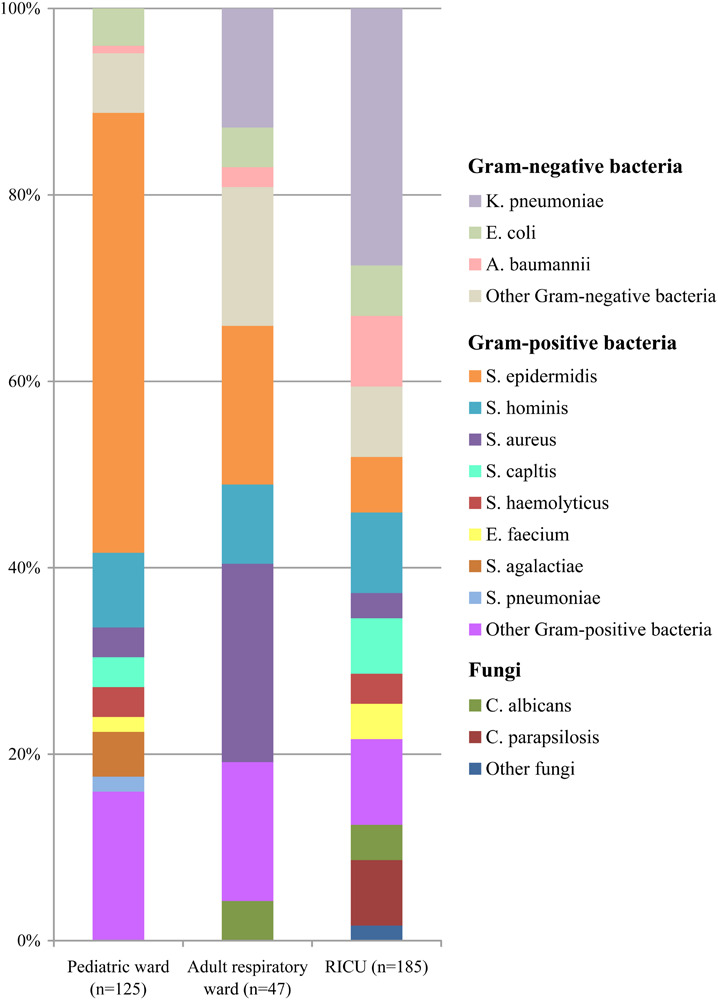
Distribution of microorganisms in positive blood cultures of lower respiratory tract infection patients from the pediatric ward, adult respiratory ward, and respiratory intensive care unit (RICU). Among the blood cultures, the frequency of Gram-positive bacteria was higher than Gram-negative bacteria in the pediatric ward and adult respiratory ward, and Gram-negative bacterial strains remained the major pathogens in the RICU. K. pneumonia, Klebsiella pneumonia; E. coli, Escherichia coli; A. baumannii, Acinetobacter baumannii; S. epidermidis, Staphylococcus epidermidis; S. hominis, Staphylococcus hominis; S. aureus, Staphylococcus aureus; S. capltis, Staphylococcus capltis; S. haemolyticus, Staphylococcus haemolyticus; E. faecium, Enterococcus faecium; S. agalactiae, Streptococcus agalactiae; S. pneumonia, Streptococcus pneumoniae; C. albicans, Candida albicans; C. parapsilosis, Candida parapsilosis.